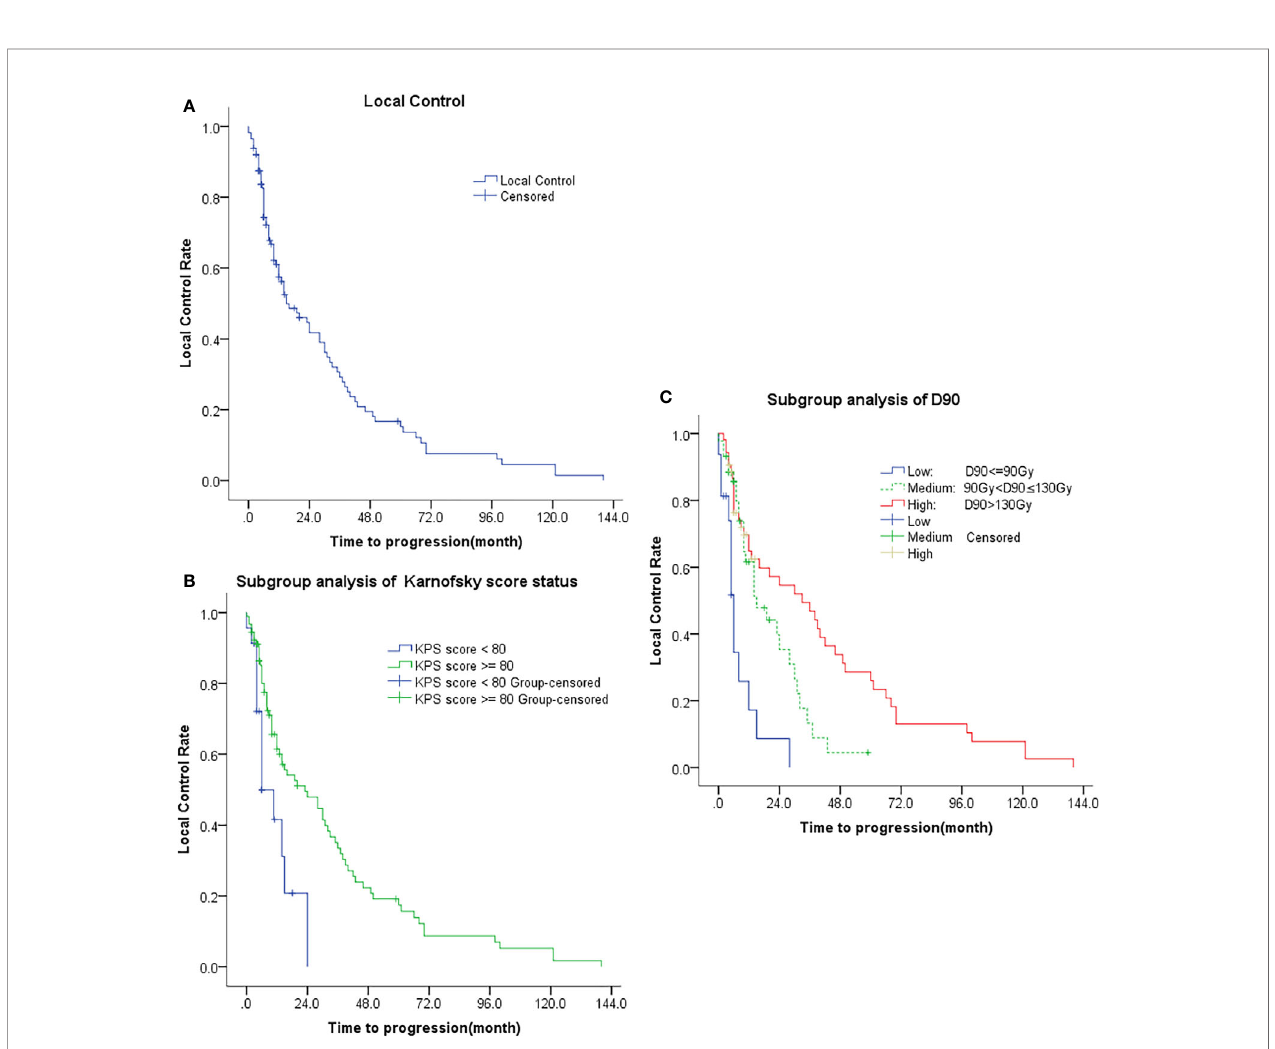
FIGURE 2 | Kaplan-Meier plots of time to progression; (A) Analysis of all patients; (B) Subgroup analysis of KPS (KPS < 80 and KPS ≥ 80); (C) Subgroup analysis of D90 (D90 ≤ 90Gy, 90Gy < D90 ≤ 130Gy, and D90 > 130Gy).